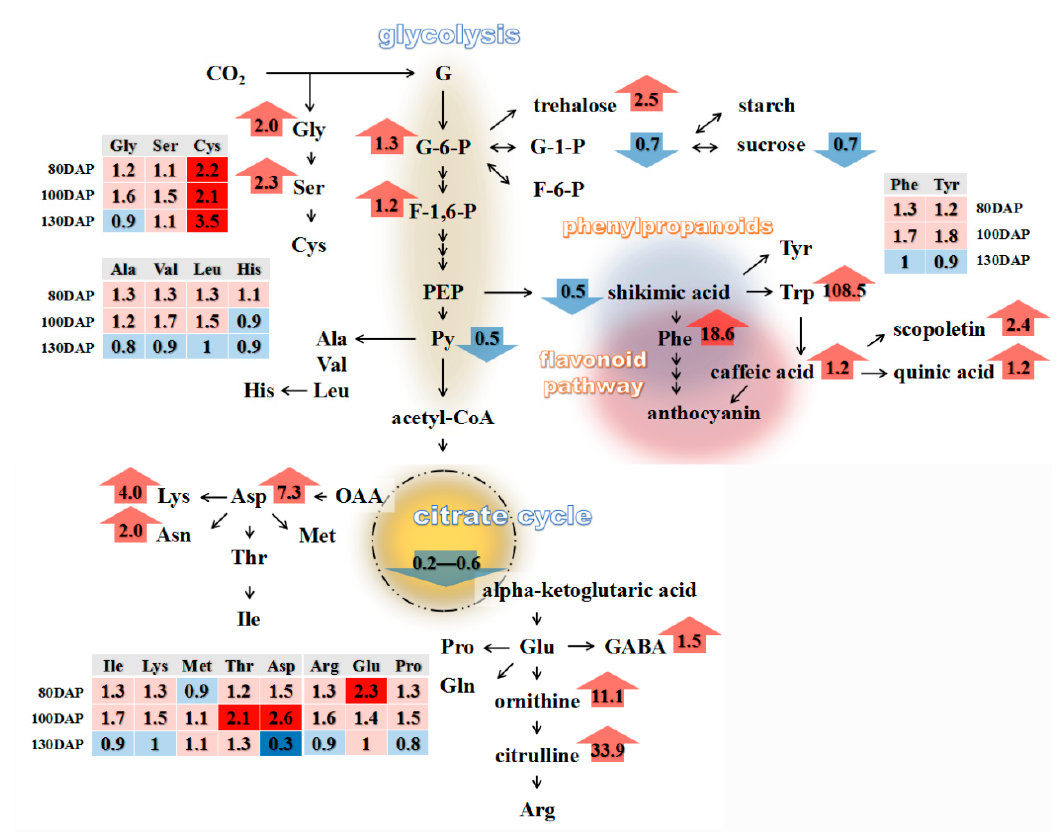
Figure 9. Metabolism was altered in the storage roots of PSP under shading. Numbers proceeded by an upward or downward arrow indicate positive (in red) or negative (in blue) abundance ratios of the metabolites. Differential amino acid contents in the developing storage roots are presented in a matrix format. Numbers in red and blue indicate positive and negative abundance ratios of the amino acids under shading, respectively. Purple-fleshed sweet potato, PSP.